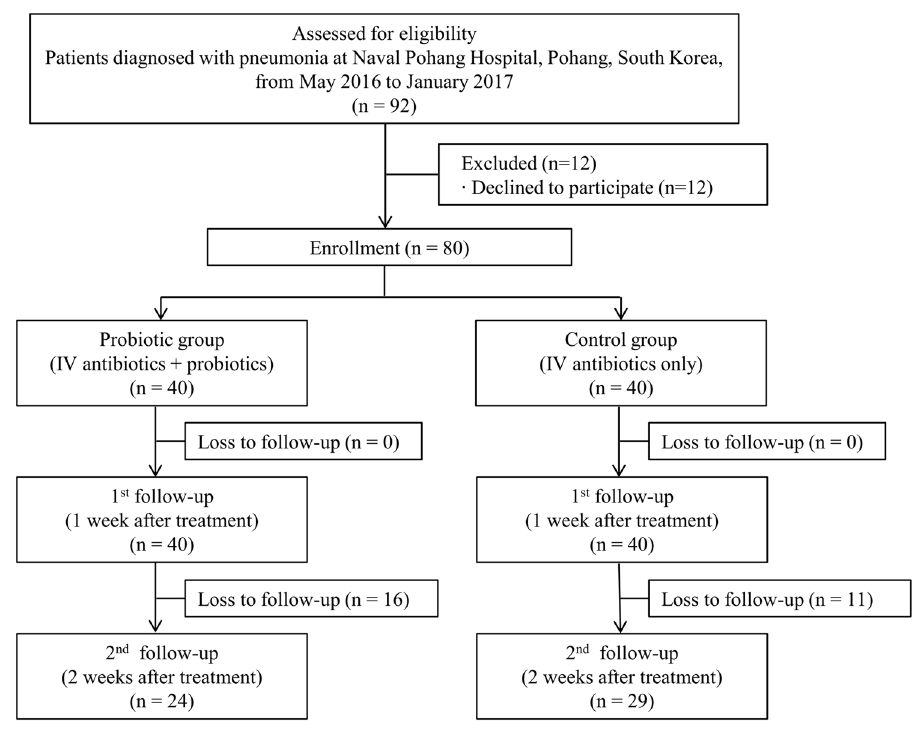
Figure 1. Flow chart of the